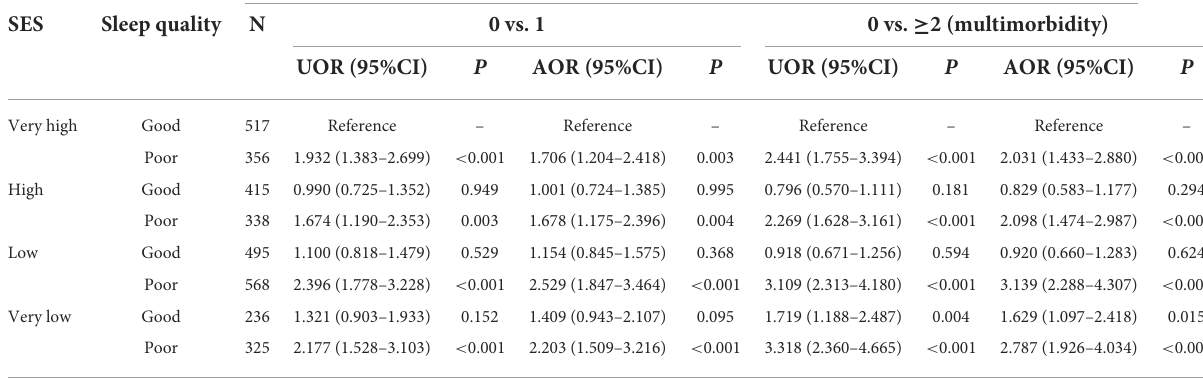
TABLE 4 Association of different combinations of SES and sleep quality with multimorbidity in older